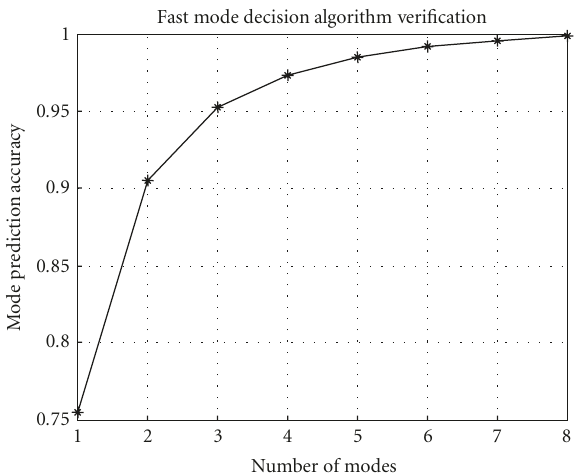
Figure 8: Number of test modes versus accuracy.